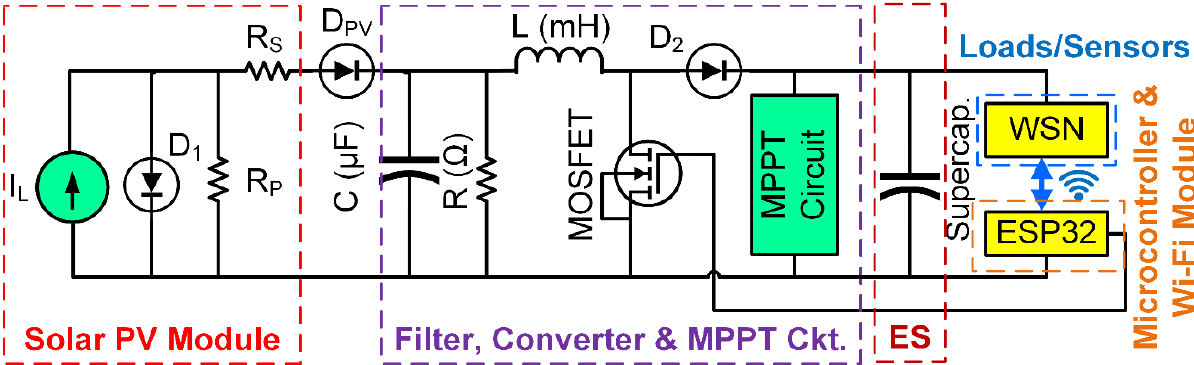
Figure 1. Electrical equivalent circuit of the proposed low-power autonomous solar PV energy harvesting system [5].